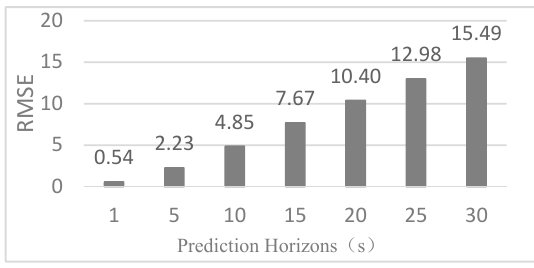
Figure 16. Root mean square error (RMSE) under different prediction horizons.